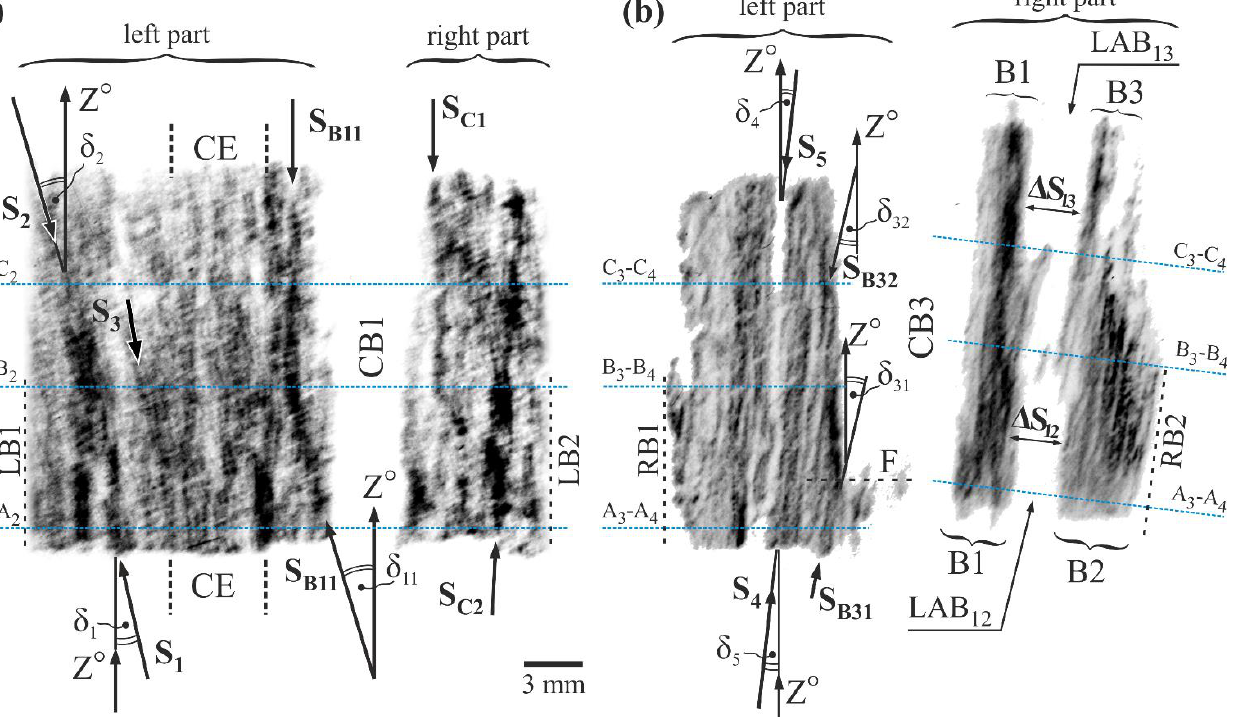
Figure 2. X-ray diffraction topograms, obtained from fragments of the surfaces L ( a ) and R ( b ). CB1 and CB3—cooling bores; CuKα radiation, 113-type reflection; Z°-axes are parallel to the blade’s Z-axis (Figure 1a). Blue dashed lines indicate images of the α and a γ′ measurement line traces.